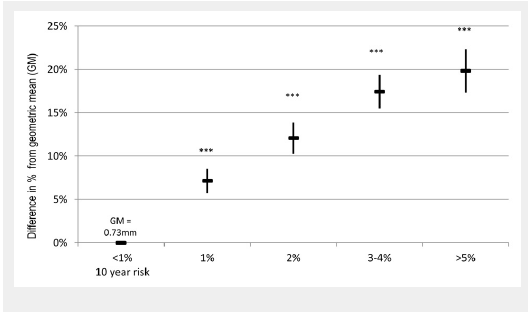
Association of SCORE with aCIMT in SAPALDIA 3. ▬ Depicts estimated %difference of the geometric mean (GM), ▌ confidence interval of estimated % change. *** p-value <0.001, between risk and reference category, α adjusted for study area (random effect)